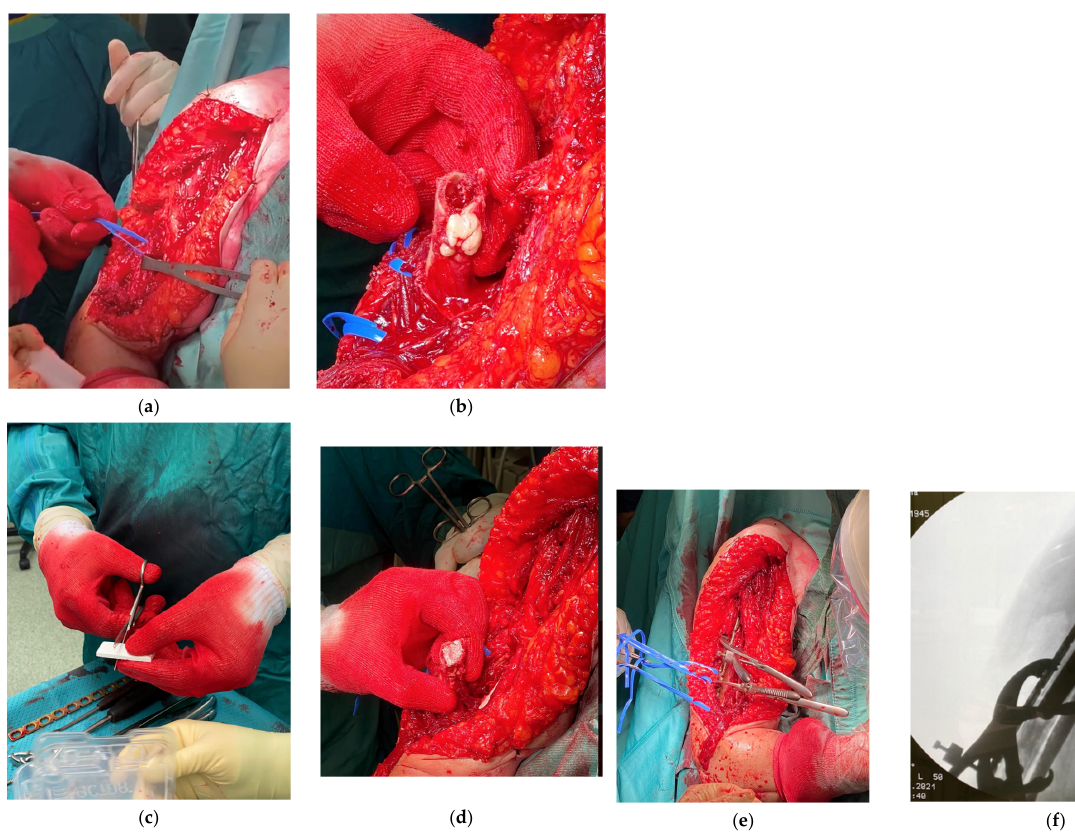
Figure 2. Treatment of IHF and its surgical steps: ( a ) extended deltopectoral approach and isolation of radial nerve; ( b ) removal of cement leakage from previous surgery; ( c , d ) preparation and inser ‐ tion in the humeral canal of synthetic bone as a scaffold for bone ingrowth and growth factors; ( e , f ). Synthesis of the fracture, equinus graft medially as mechanical strut stabilised through plate and cerclages and intra ‐ operative fluoroscopy after strut positioning.